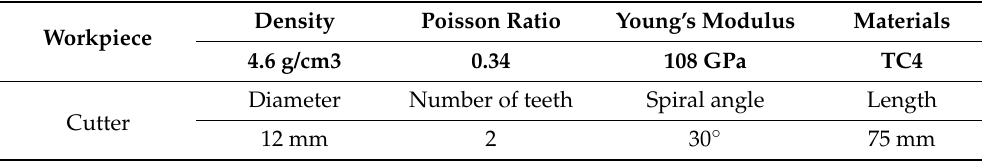
Table 3. Workpiece and tool parameters.